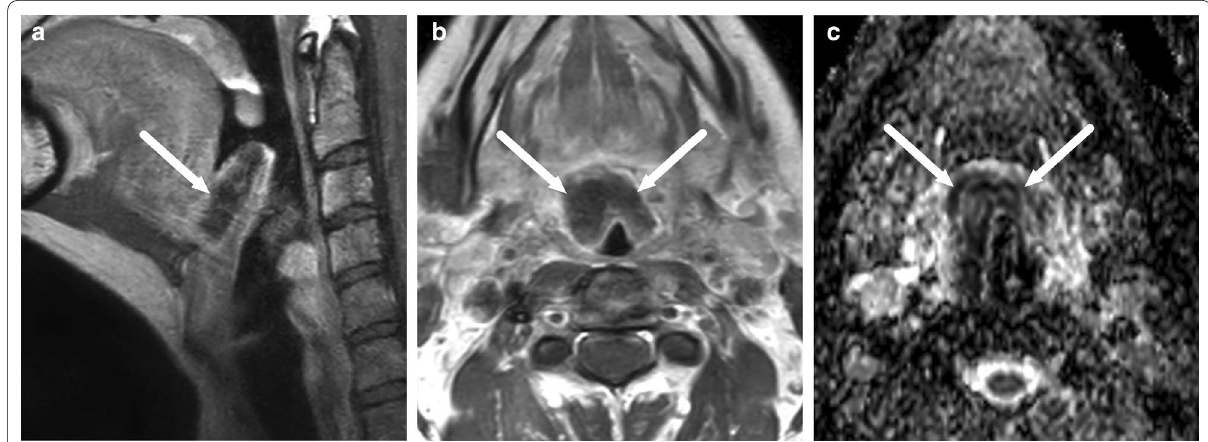
Fig. 24 An epiglottic abscess (arrows) on sagittal ( a ) and axial ( b ) post-contrast T1-weighted images and on an axial ADC map ( c